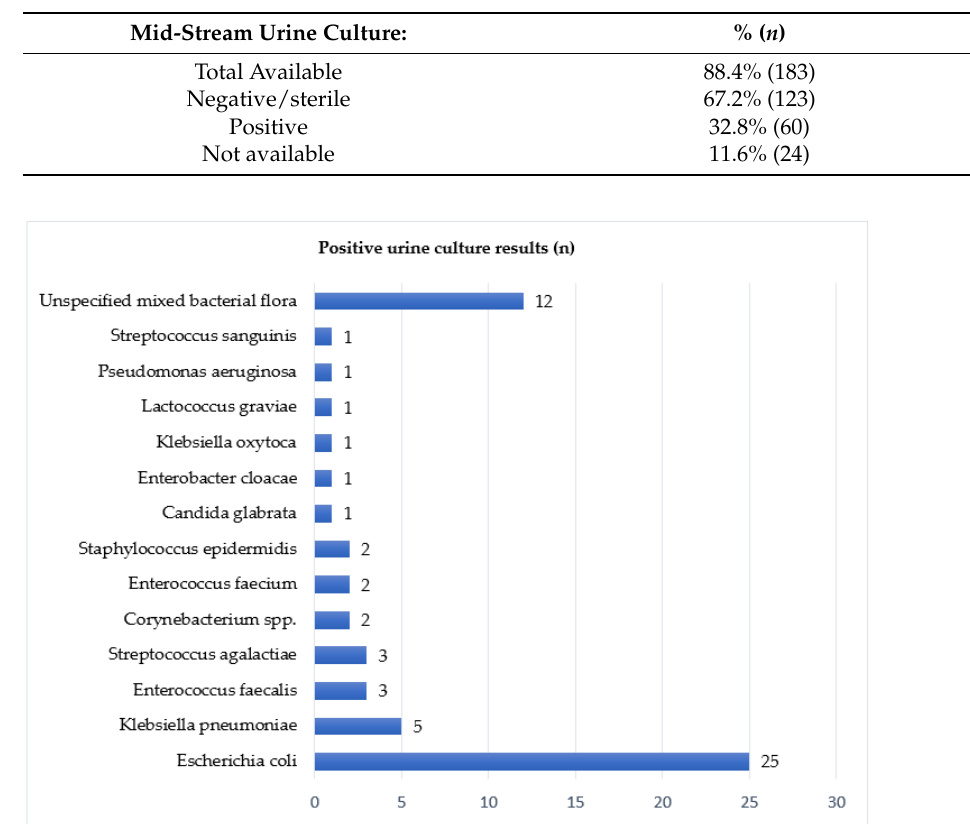
Table 2. Mid-stream urine culture results.